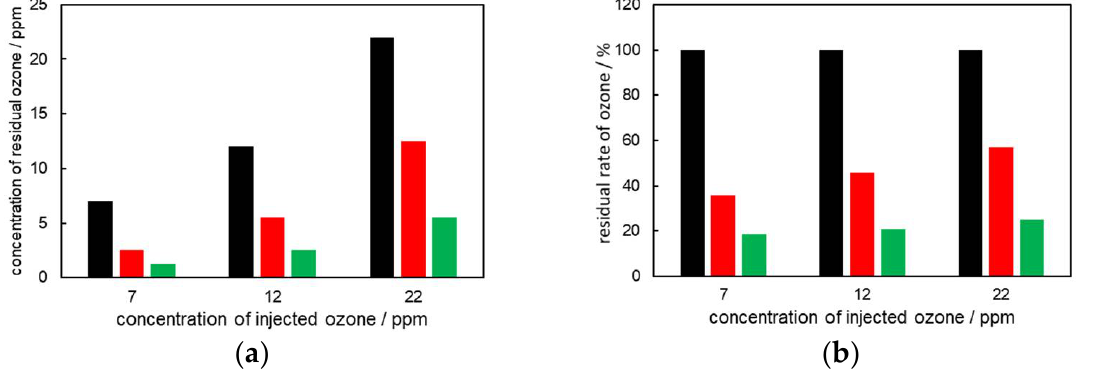
Figure 5. Gas chromatograms of gas components at reactor outlet by activated carbon tube solvent extraction method on each reaction (red: photocatalyst + UV irradiation, green: ozone + UV irradia- tion, blue: photocatalyst + ozone + UV irradiation).